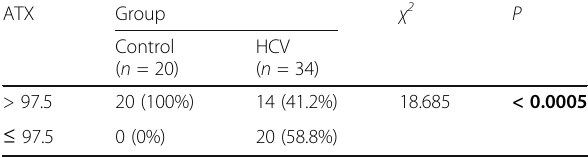
Data expression: frequency (%), P chi-square